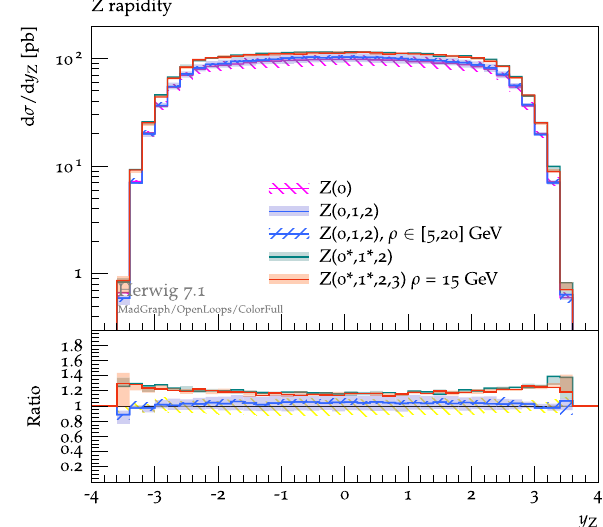
Fig. 19 Data [63] comparison to the D -parameter observable, which is sensitive to the second emission